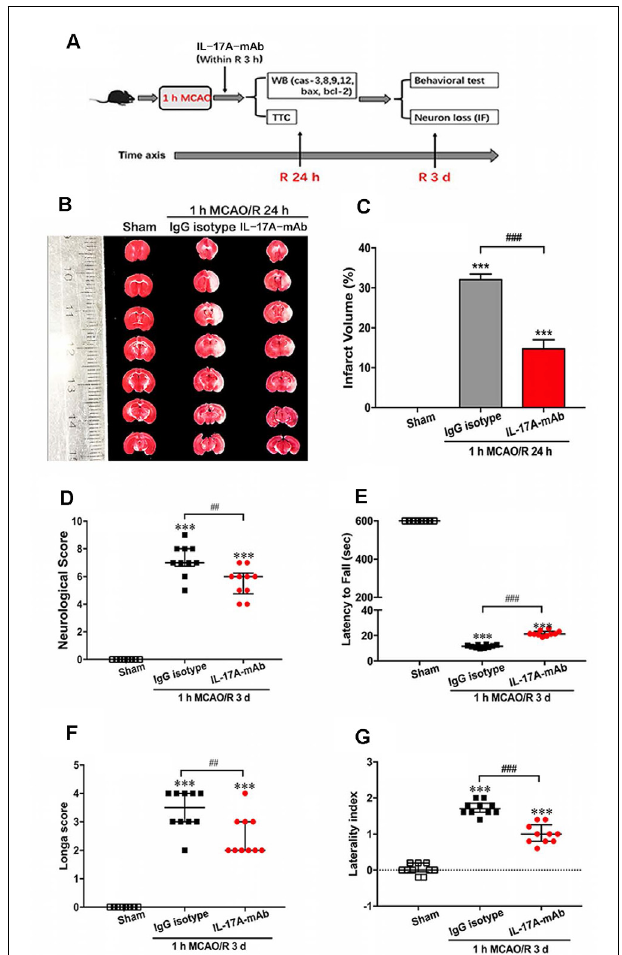
FIGURE 1 | Interleukin-17A (IL-17A)–neutralizing monoclonal antibody (mAb) improved the neurological outcome of mice with ischemic stroke. (A) The diagram of experimental design showed that the intracerebroventricular injection of IL-17A-neutralizing mAb (2 µ g, i.c.v) or IgG isotype within 3-h reperfusion after 1-h MCAO treatment. At 24 h of reperfusion, the mice were sacrificed for Western blot and triphenyl tetrazolium chloride (TTC) staining. At 3 days of reperfusion, the mice were used to evaluate the neurological function and then sacrificed for immunofluorescent staining. (B) At 24 h of reperfusion after 1-h MCAO, the infarct size of IL-17A-neutralizing mAb group was significantly smaller than the IgG isotype group. (C) Bar graph showed the statistical analysis results of infarct size among three groups ( n = 6 per group). Data are presented as mean ± SEM; ∗∗∗ p < 0.001 vs. sham group; ### p < 0.001 vs. 1-h MCAO/R 24 h + IgG isotype group. In addition, the IL-17A-neutralizing mAb could significantly improve the neurological function that included neurological score (D) , the latency to fall of wire hanging (E) , the Longa score (F) , and the laterality index of corner test (G) of mice following 1 MCAO/R 3 days ( n = 10 per group). Data are presented as quartile; ∗∗∗ p < 0.001 vs. s ham group; ## p < 0.01, ### p < 0.001 vs. 1-h MCAO/R 24 h + IgG isotype